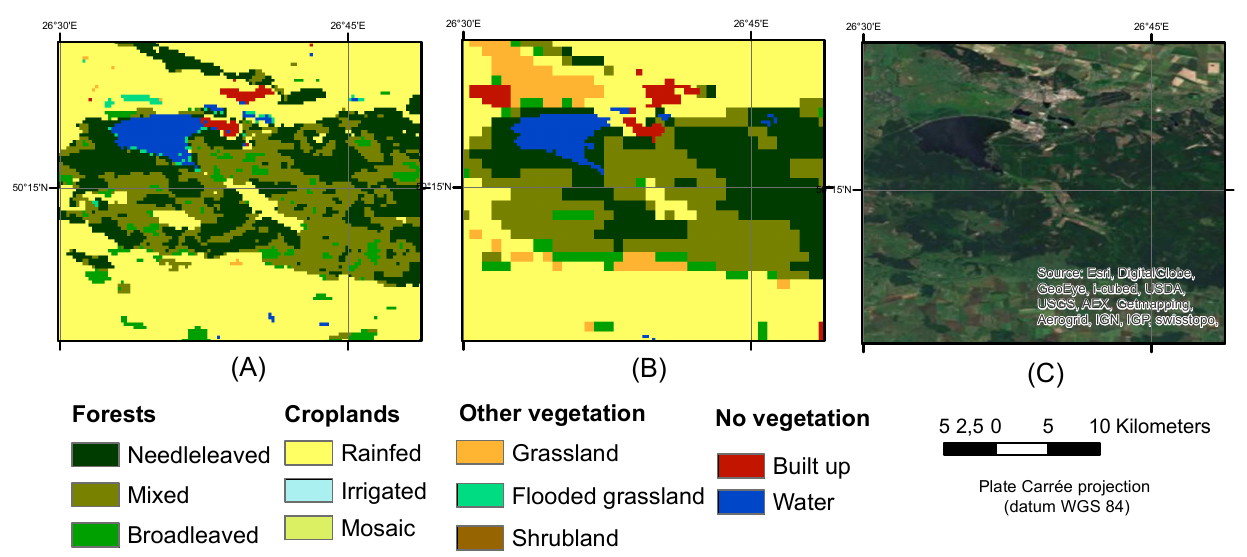
Figure 5. Qualitative difference, in the Eurasian region, between the classification result with a tile of 400 pixels ( A ) and the original reference data (GLC 2000) ( B ). An orthophoto ( C ) (from ESRI online imagery, 2012) is shown for